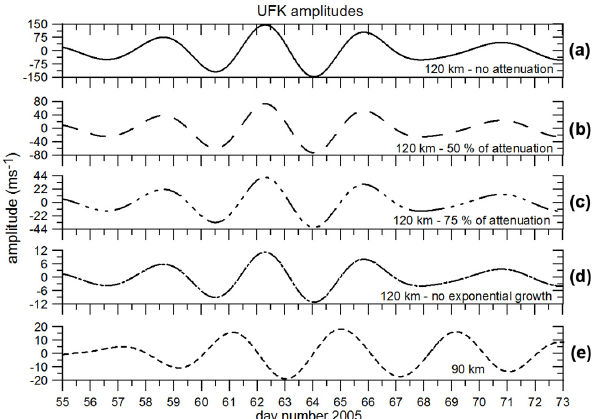
Fig. 1. UFK zonal winds amplitudes at 120km. Three different cases for the vertical propagation function were considered: (a) no attenuation, (b) 50% of attenuation, (c) 75% of attenuation and (d) without exponential growth. Panel (e) shows the UFK zonal wind at 90km measured over S˜ao Jo˜ao do Cariri.